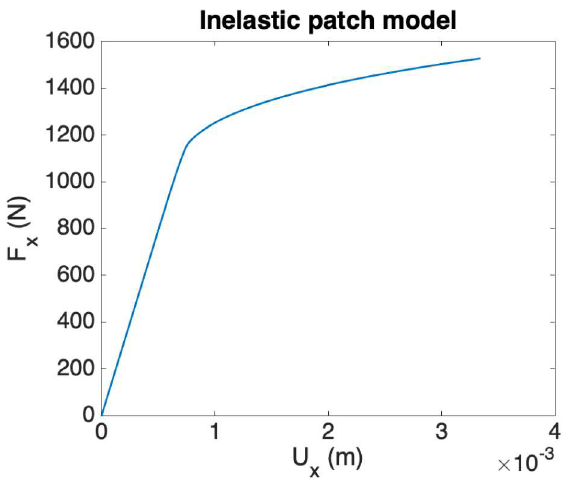
Fig. 22. Applied force versus induced displacement on the patch surface x = H ω x in the inelastic